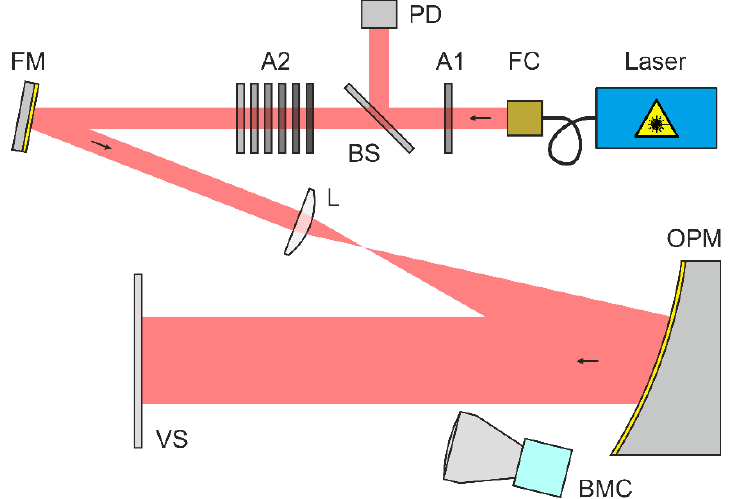
Figure A1. Experimental setup for measuring the laser beam diameter.